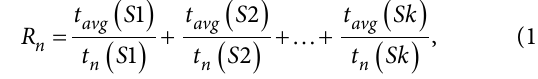
Table 1. The proposed criteria set and their weights Criteria Optimum C1 MAX